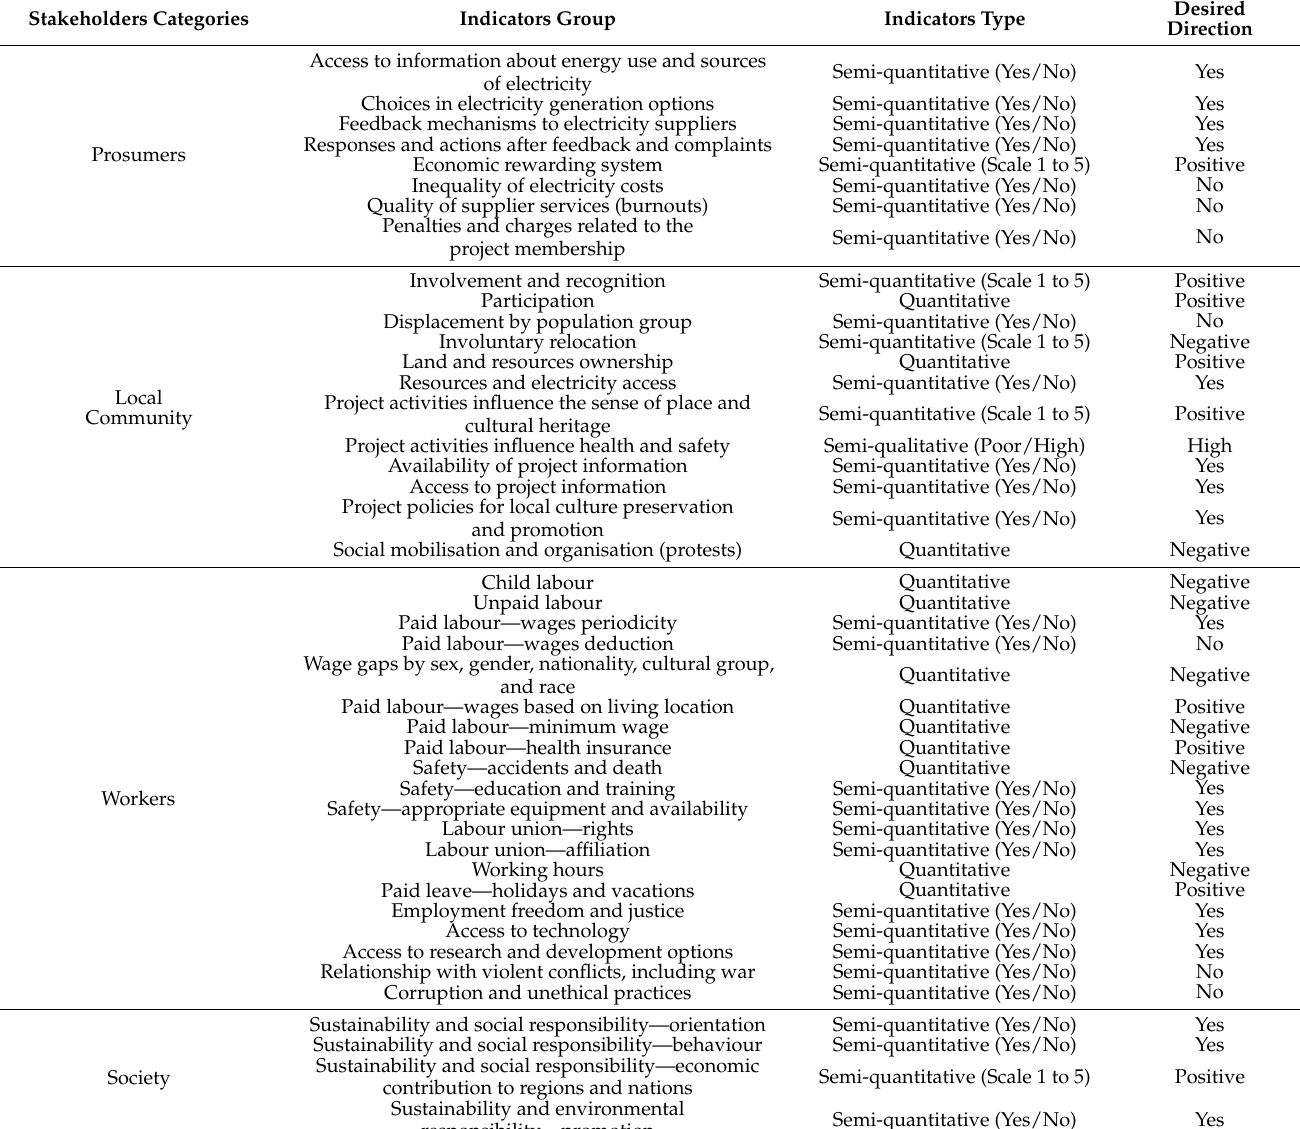
Table 3. Selected s-LCA indicators group for Solidarity Oriented REC of San Giovanni a